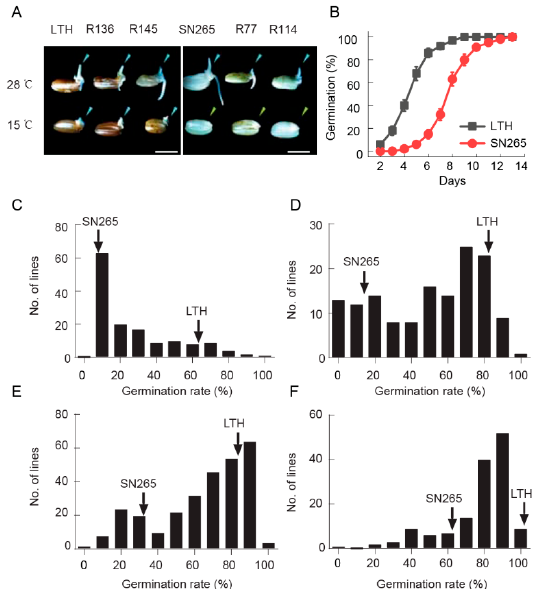
Figure1. Theseedgerminationoftwoparentsandtheirrecombinantinbredlines(RILs)atnormal(28 ◦ C) and low (15 ◦ C) temperatures. ( A ). The germination phenotype of the two parents, Lijiangxintuanheigu (LTH) and Shennong265 (SN265), as well as the four RIL lines incubated for 3 days at 28 ◦ C and for 6 days at 15 ◦ C. R136 and R145 have 11 positive QTLs, whereas R77 and R144 have no positive QTLs. The bars = 5 mm; ( B ). The germination behavior of LTH (black) and SN265 (red) under low temperatures at 15 ◦ C. The means are shown in triplicate; ( C – F ). The frequency distribution of low-temperature germinability in the RILs incubated for 5 days ( C ), 6 days ( D ), 7 days ( E ), and 8 days ( F ). Arrowheads indicate LTH or